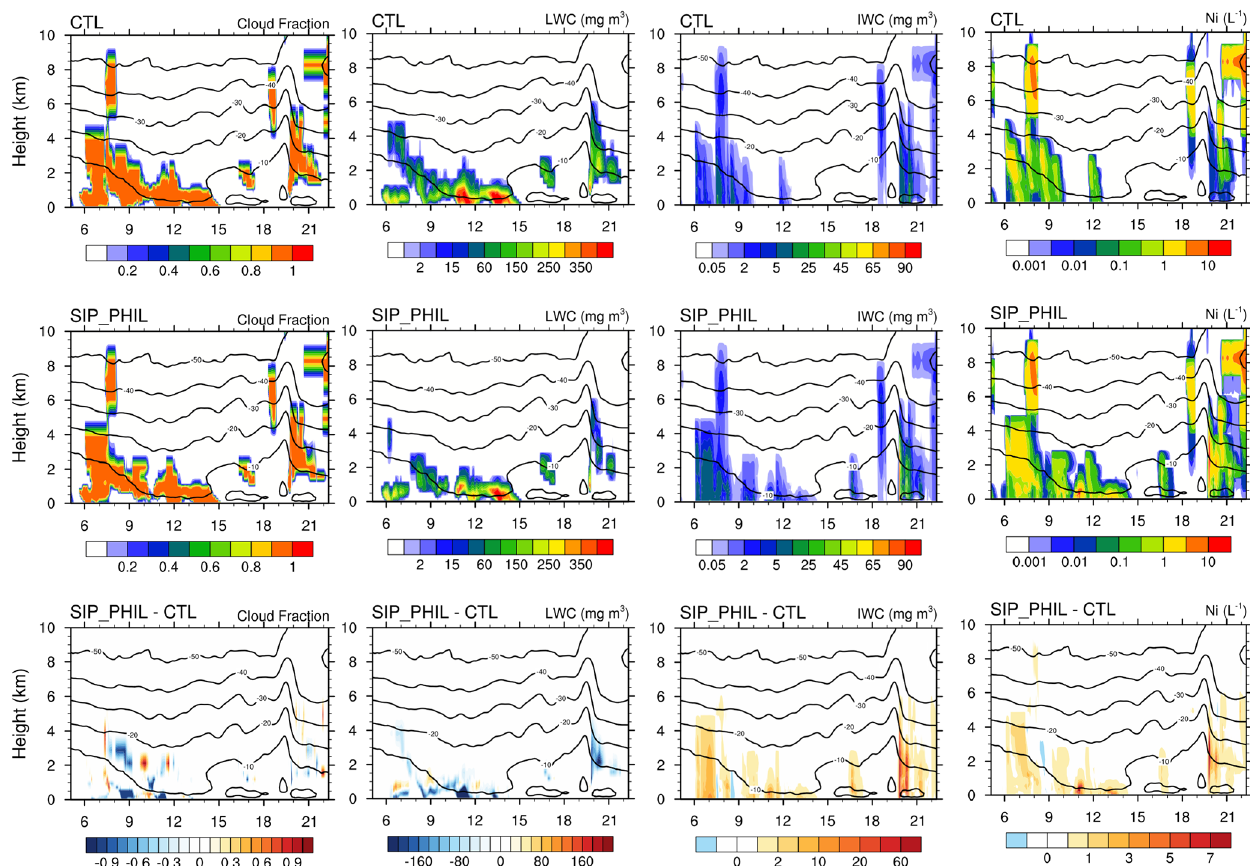
Figure 5. Time–height cross section of cloud fraction (first column), LWC (second column), IWC (third column), and ice crystal number concentration (fourth column) from CTL (first row) and SIP_PHIL (second row) and the differences between SIP_PHIL and CTL (SIP_PHIL minus CTL, third row).